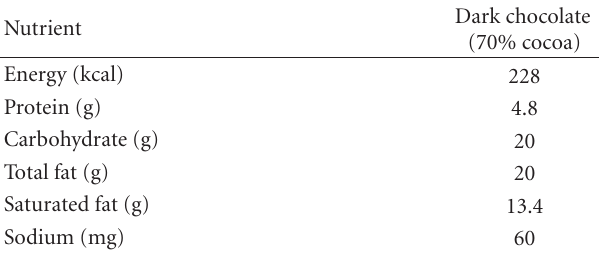
Table 1: Nutrient composition of the dark chocolate used in the study